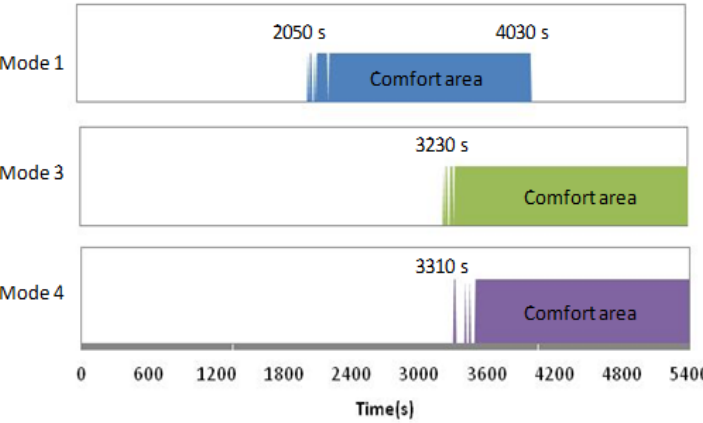
Table 5. Energy consumption after 90 min. Figure 12. Time period of each mode corresponding to the comfort area. Figure 12. Time period of each mode corresponding to the comfort area.